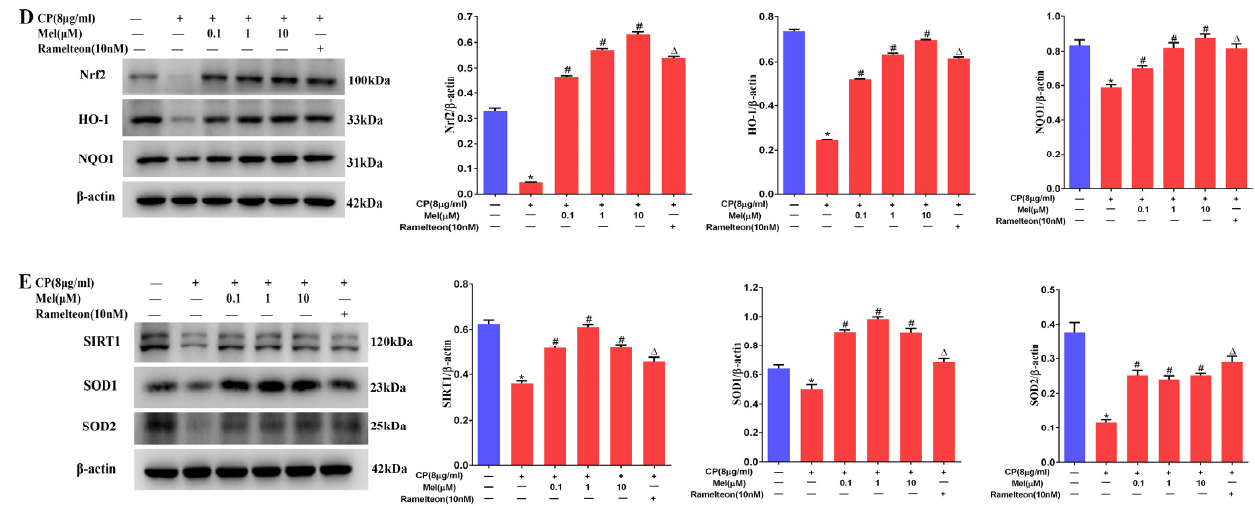
Figure 10. Melatonin could attenuate the downregulation of the MT1, MT2, and SIRT1/Nrf2 signaling pathways by cisplatin in Leydig cells. ( A ) Determination of MT1 and MT2 protein levels was performed by Western blotting in Leydig cells treated with different concentrations of melatonin for 24 h. The blots were quantified using Image J software. ( B ) MT1 immunofluorescence in Leydig cells treated with 1 μ M of melatonin. MT1 was tagged with green fluorescence. The nucleus was labeled with DAPI (scale bar = 20 μ m). ( C ) MT2 immunofluorescence in Leydig cells treated with 1 μ M of melatonin. MT1 was tagged with red fluorescence. The nucleus was labeled with DAPI (scale bar = 20 μ m). ( D ) Determination of Nrf2, HO-1, and NQO1 protein levels was performed by Western blotting in cisplatin-induced Leydig cells pretreated with different concentrations of melatonin or ramelteon. The blots were quantified using Image J software. ( E ) Determination of the SIRT1, SOD1, and SOD2 protein levels was performed by Western blotting in cisplatin-induced Leydig cells pretreated with different concentrations of melatonin or ramelteon. The blots were quantified using Image J software. CP, cisplatin. Mel, melatonin. Data are presented as the mean ± SEM ( N = 4 per group). * p < 0.05 or ** p < 0.01 compared with controls. # p < 0.05 compared with CP groups. ∆ p < 0.05 compared with CP groups.